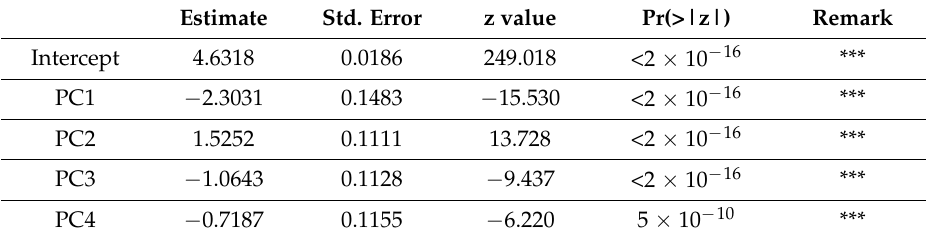
Table 3. Coefficients of Poisson